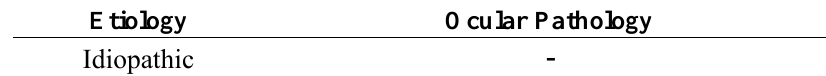
Table 1. Main etiologies and pathological conditions for primary and secondary Limbal Stem Cell Deficiency